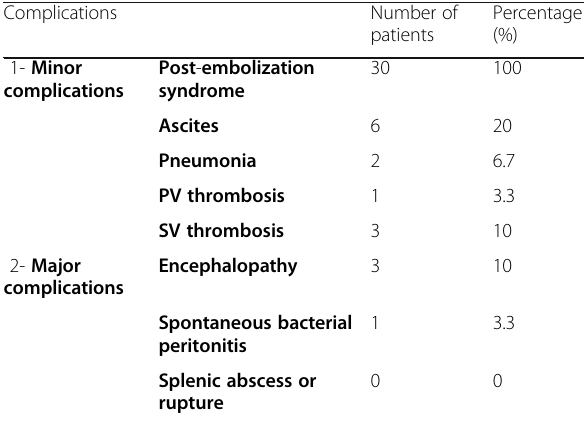
Table 8 Post-procedure complications in the study group